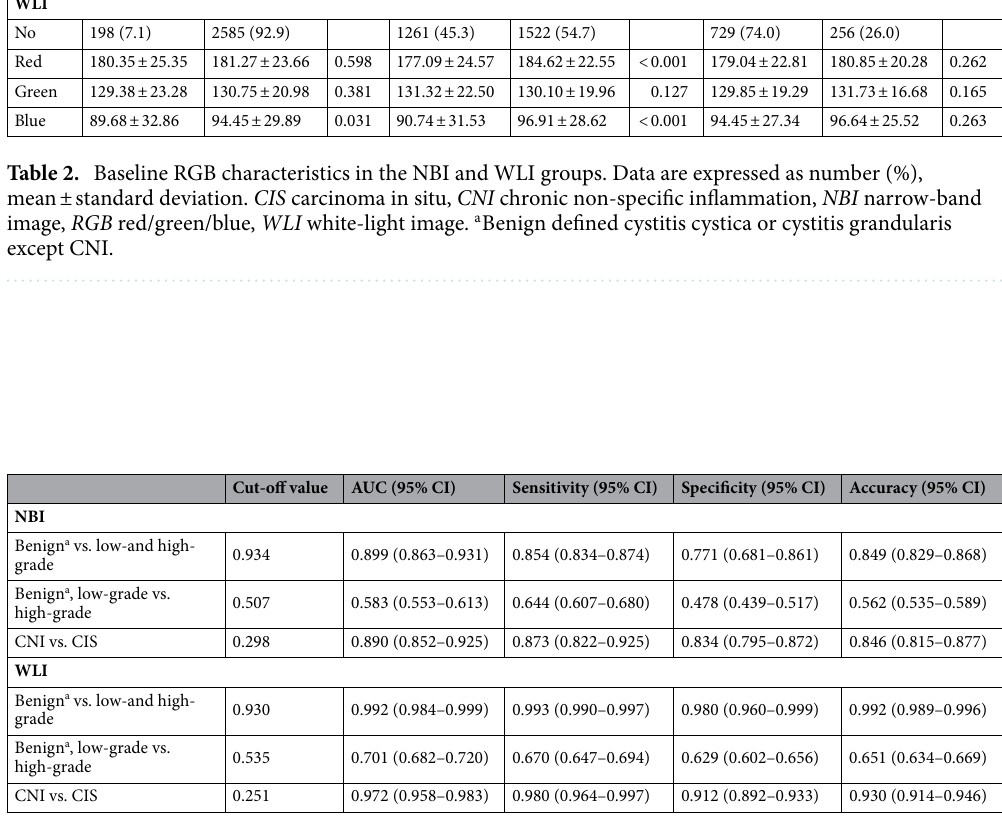
Table 3. Diagnostic performance and differentiation of tumor grade according to tumor color by SVM. Data are presented as median (interquartile range). AUC area under the receiver operating characteristic curve, CI confidence interval, CIS carcinoma in situ, CNI chronic non-specific inflammation, NBI narrow-band image, SVM support vector machine, WLI white-light image. a Benign defined cystitis cystica or cystitis grandularis except